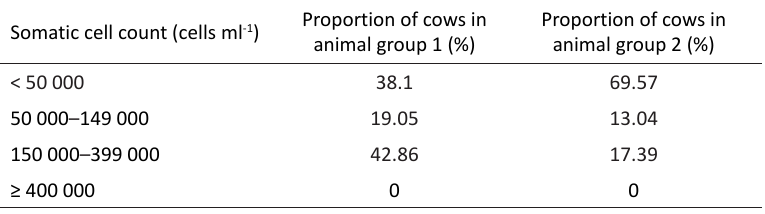
Table 6. The proportion (%) of cows in different levels of somatic cell count (cells ml -1 ) in the observed animal groups at the beginning of the experiment (baseline situation)